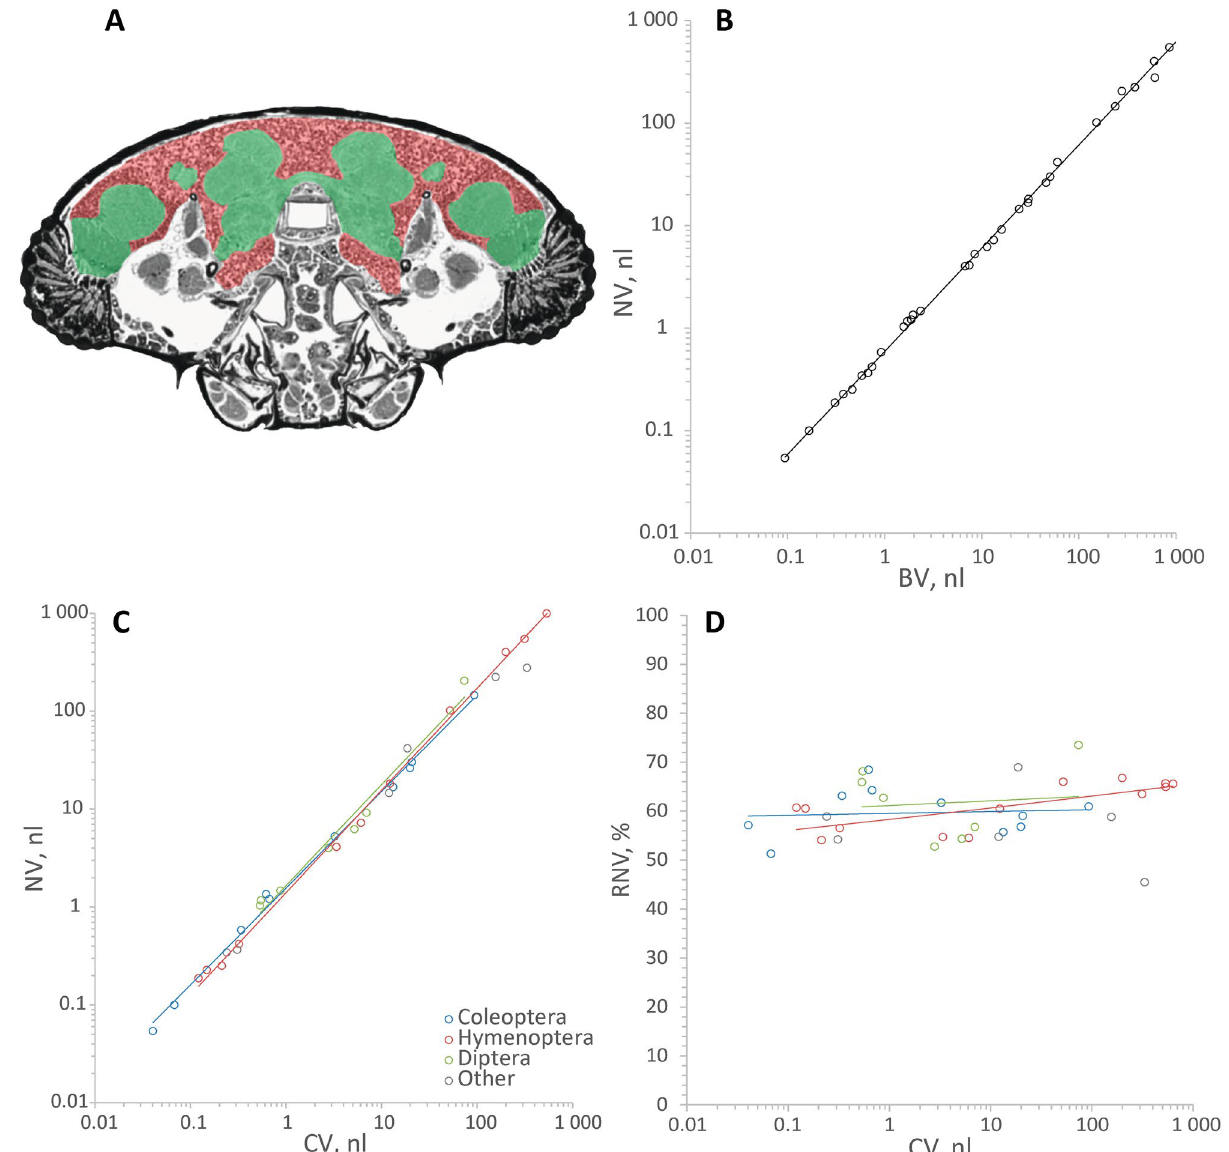
Figure 1. Scaling of neuropil in insect brains. ( A ) neuropil (green) and cell body rind (red) on a histological cross section of head of featherwing beetles Acrotrichis grandicollis (Coleoptera: Ptiliidae); ( B ) dependence of neuropil volume (NV) on brain volume (BV) in insects in general; ( C ) dependence of NV on cell body rind volume (CV) in major insect orders; ( D ) dependence of relative neuropil volume (RNV) on CV in major insect orders. All scales are logarithmic, except Y-axis in ( D ). For results of allometric analysis, see Table